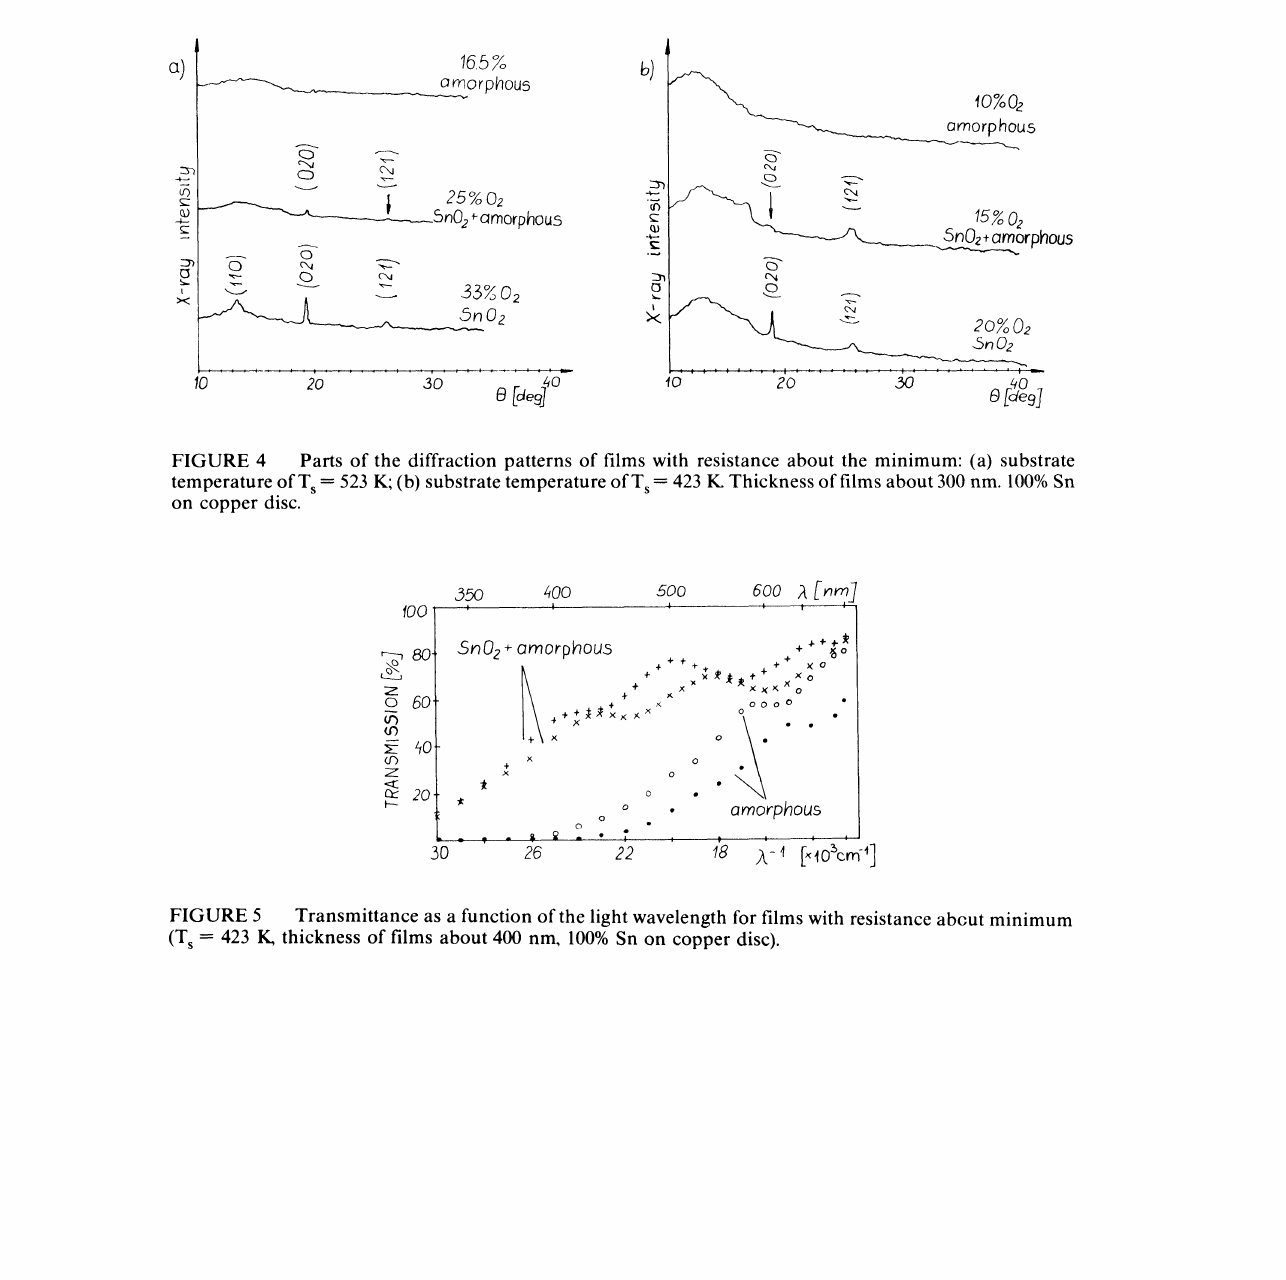
Parts of the diffraction patterns of films with resistance about the minimum: (a) substrate temperature ofT 523 K; (b) substrate temperature ofT 423 K. Thickness of films about 300 rim. 100% Sn on copper disc.